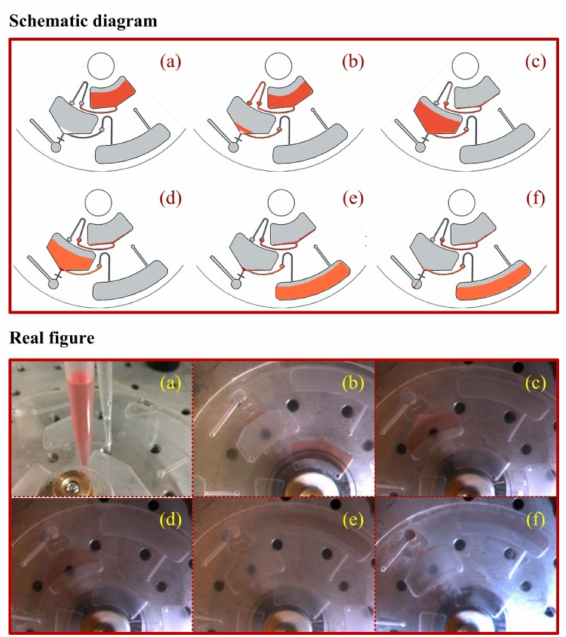
Figure 6. ( Top ) Schematics of salt-controlled ionic liquid dispersive liquid-liquid microextraction (SC-IL-DLLME) dye solution in operation (ionic liquid, white; NaClO 4 solution, yellow). ( Bottom ) Corresponding experimental stroboscopic images of SC-IL-DLLME dye solution on the disc (ionic liquid, colorless; NaClO 4 solution, colorless). The different panels are: ( a ) loading ionic liquid (IL), NaClO 4 and dye (red), mixing IL and dye; ( b ) priming Siphon Valve 1, transporting from the mixing chamber to the separation chamber, ( c ) mixing IL and NaClO 4 , dispersing IL micro droplets; ( d ) centrifugation and depositing IL in the separation chamber, ( e ) priming Siphon Valve 2, transporting supernatant (pink) from the separation chamber to the waste chamber, and ( f ) bursting Capillary Valve 3, transporting enriched IL (dark red) phase from the separation chamber to the detection